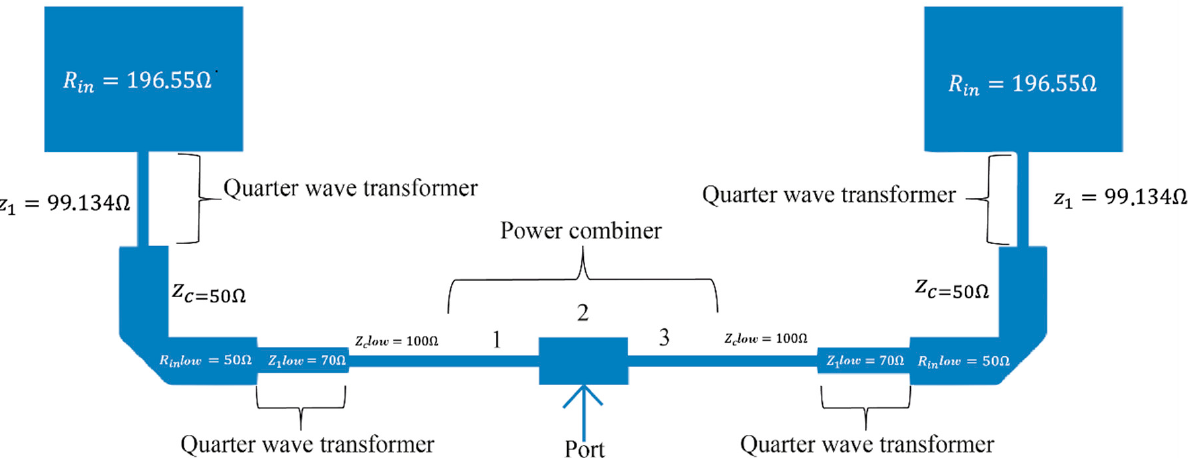
Figure 4. 1×2 array of square patch antenna with quarter-wave coupling. Figure 4. 1 × 2 array of square patch antenna with quarter-wave coupling.